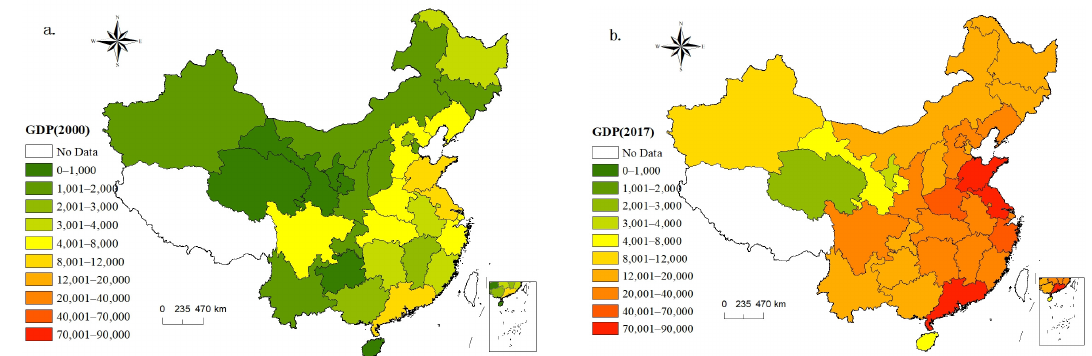
Figure 3. The temporal and spatial distribution of economic scale (100 million yuan) in China’s provinces: ( a ) spatial distribution of economic scale in 2000; ( b ) spatial distribution of economic scale in 2017.